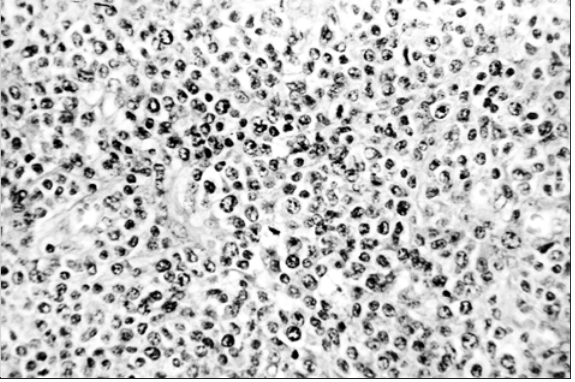
Figura 7 – Linfoma difuso de grandes células: proliferação difusa de células grandes com nucléolos ora únicos e centrais, ora múltiplos e